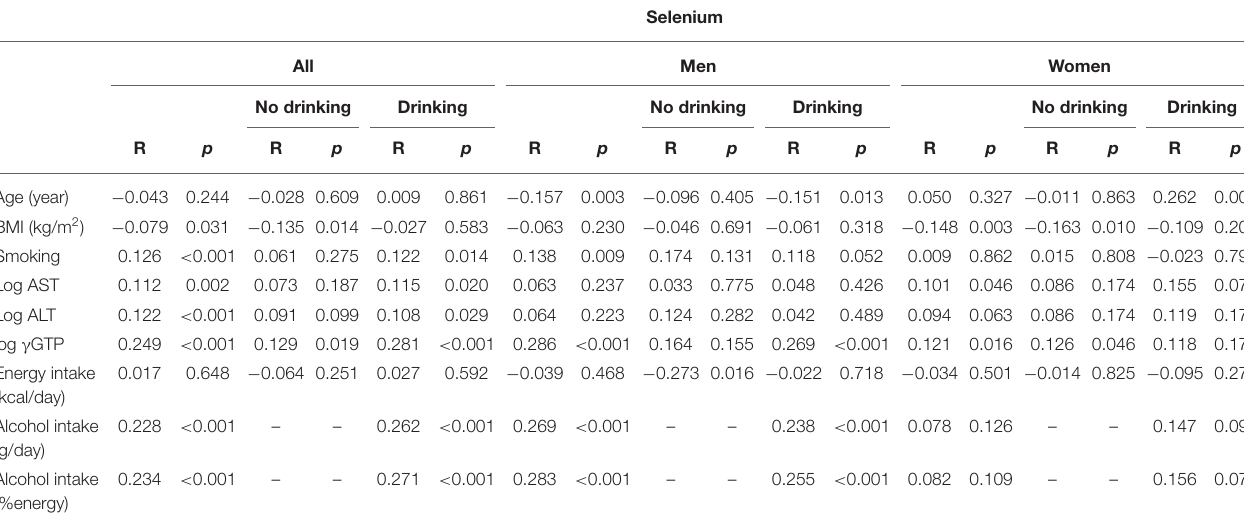
TABLE 2a | Univariate correlation between clinical parameters and selenium in participants consuming and not consuming